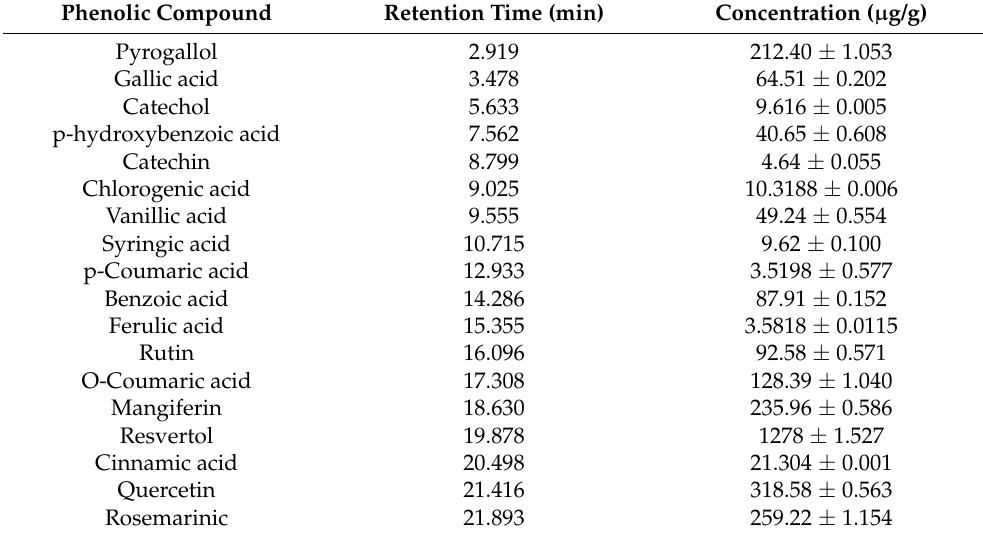
Table 2. Identification of the main phenolic compounds present in Mango Peel Extract